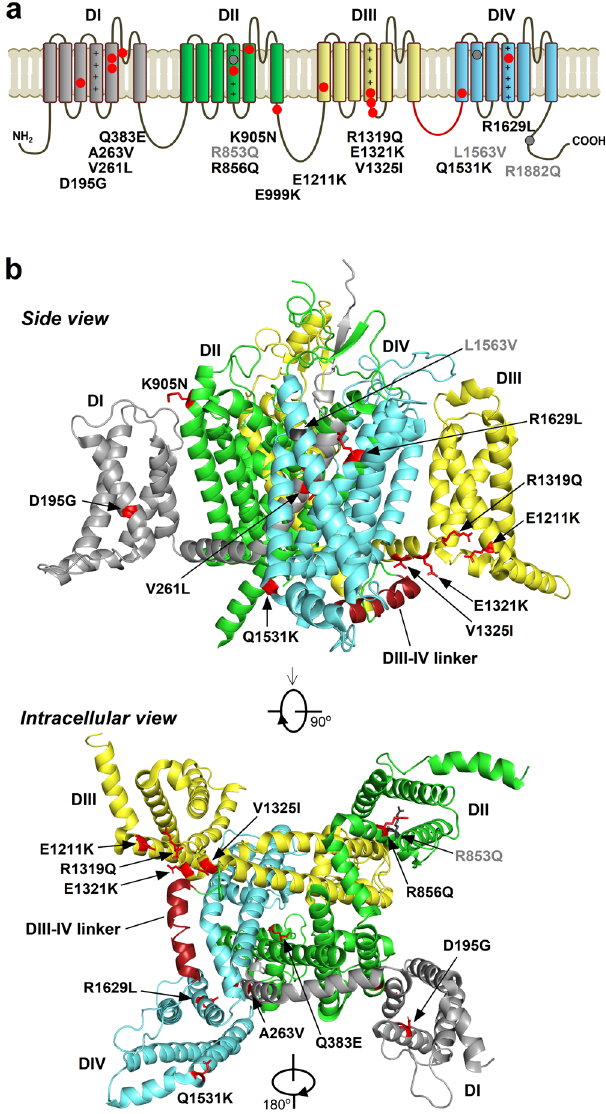
Fig. 1 Nav1.2 channel and the locations of the functionally studied mutations. Note the color-coded four domains (DI – DIV), the positive charges of segment 4 (S4) on DI – DIV, and the inactivation gate (DIII – DIV linker) marked in red. a Linear representation of the full-length Na v 1.2 channel with the mutations studied here (red) or previously (gray) 7 . b Cryo-electron microscopy structure of Na v 1.2 24 . The mutations are distributed in the pore module, the four peripheral voltage-sensing domains, the intracellular loops, and the C-terminus. Residues affected by the mutations are shown as